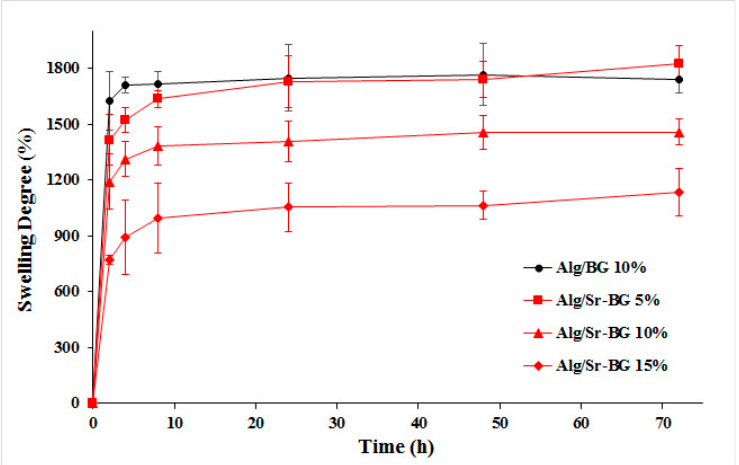
Figure 6. The trend of the swelling degree (%) of the Alg/BG and Alg/Sr-BG (5%, 10% and 15%) hydrogels’ time dependence over a period of 72 h . hydrogels’ time dependence over a period of 72 h.